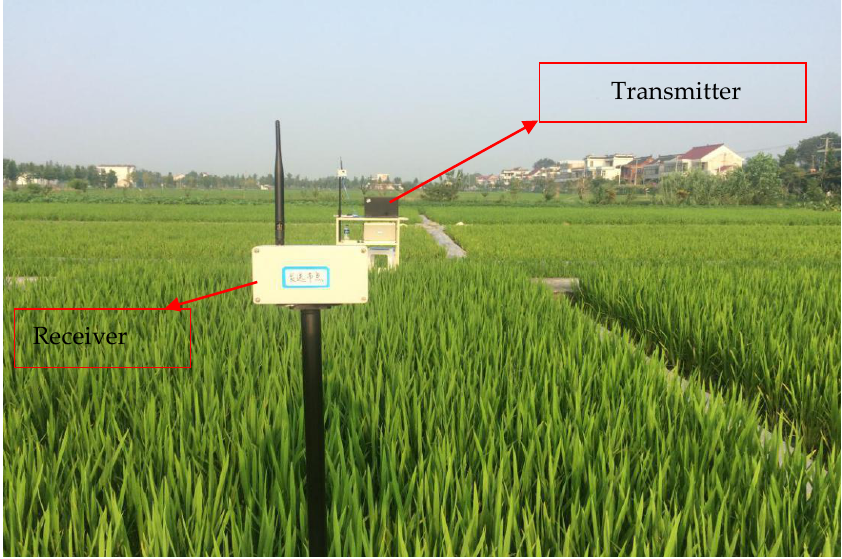
Figure 2. Field experiment site map.